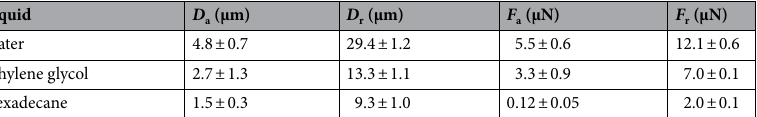
Table 2. Average values with standard deviations of the range of attraction on approach ( D a ) and retraction ( D